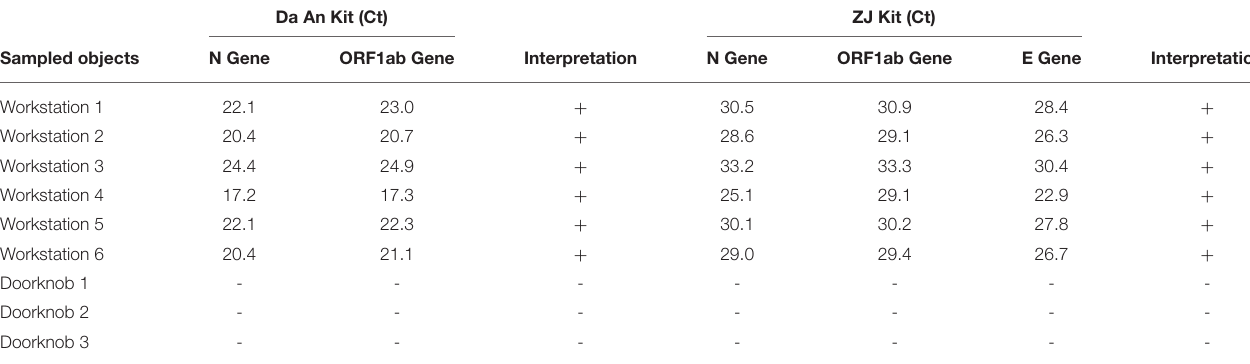
Da An Kit (Ct) ZJ Kit (Ct) Sampled objects N Gene ORF1ab Gene Interpretation N Gene ORF1ab Gene E Gene